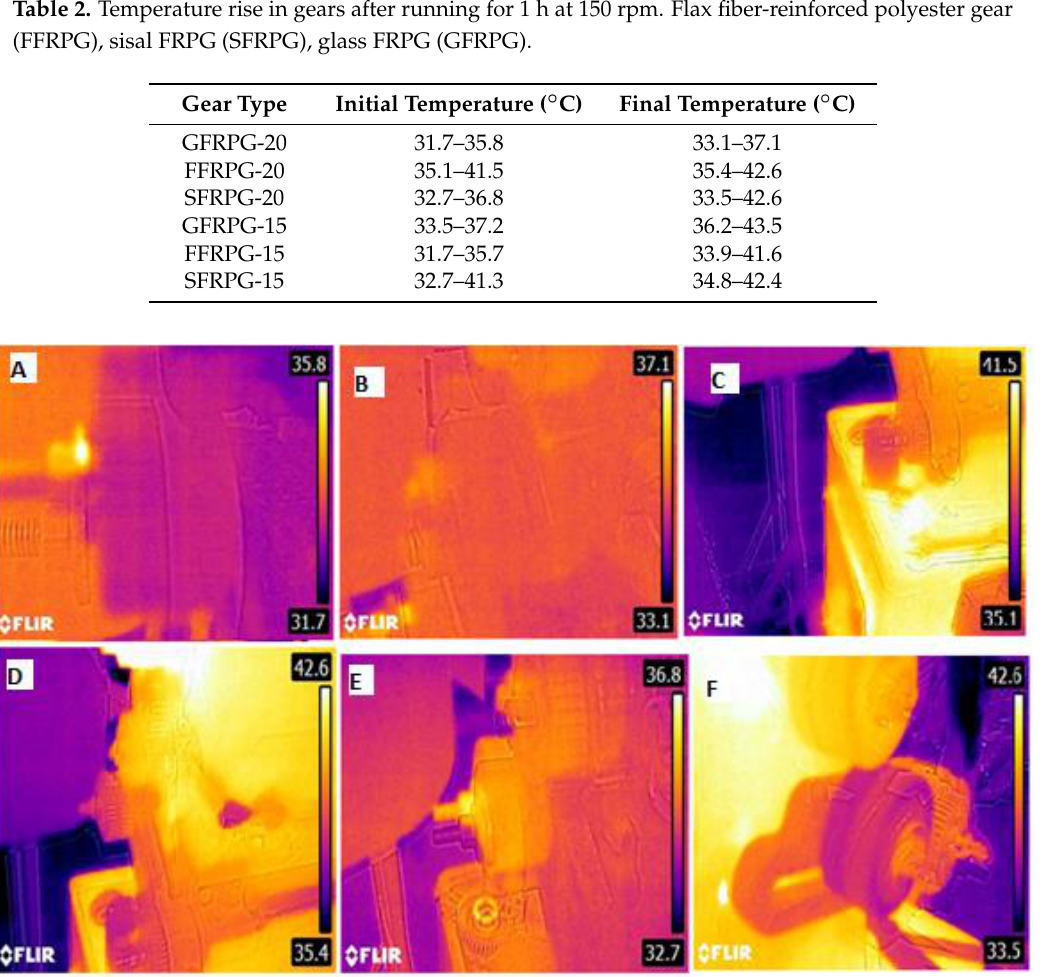
Figure 10. Thermal images. ( A ) Initial temperature of GFRPG-15. ( B ) Final temperature of GFRPG-15. ( C ) Initial temperature of FFRPG-15. ( D ) Final temperature of FFRPG-15. ( E ) Initial temperature of SFRPG-15. ( F ) Final temperature of SFRPG-15.